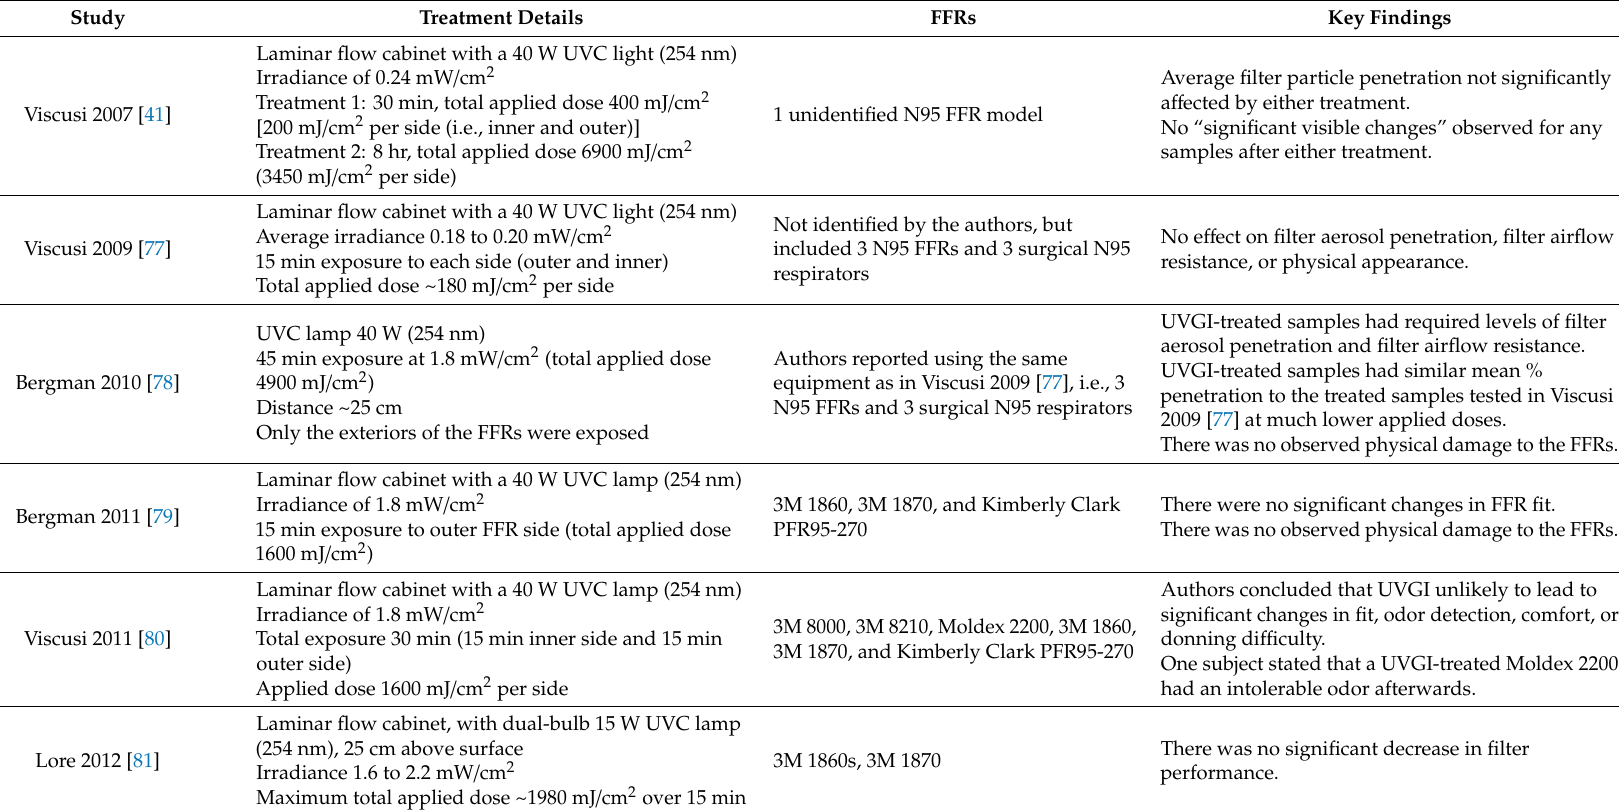
Table 6. Studies reporting on the e ff ects of ultraviolet germicidal irradiation (UVGI) on filtering facepiece respirators